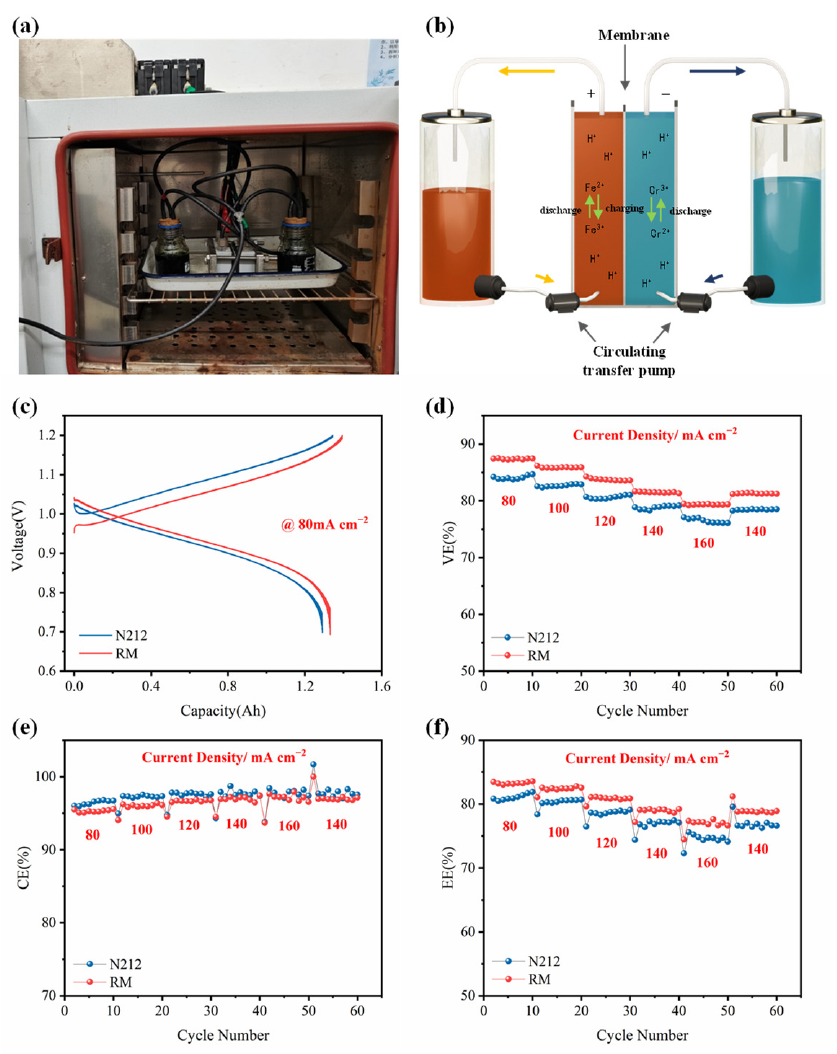
Figure 4. ( a ) A photograph of the battery, ( b ) the battery operation schematic. Effect of RM on ICFB performance: second constant current charge/discharge curves at ( c ) 80 mA cm − 2 , ( d ) VE, ( e ) CE, and ( f ) EE versus cycle number at different current densities.